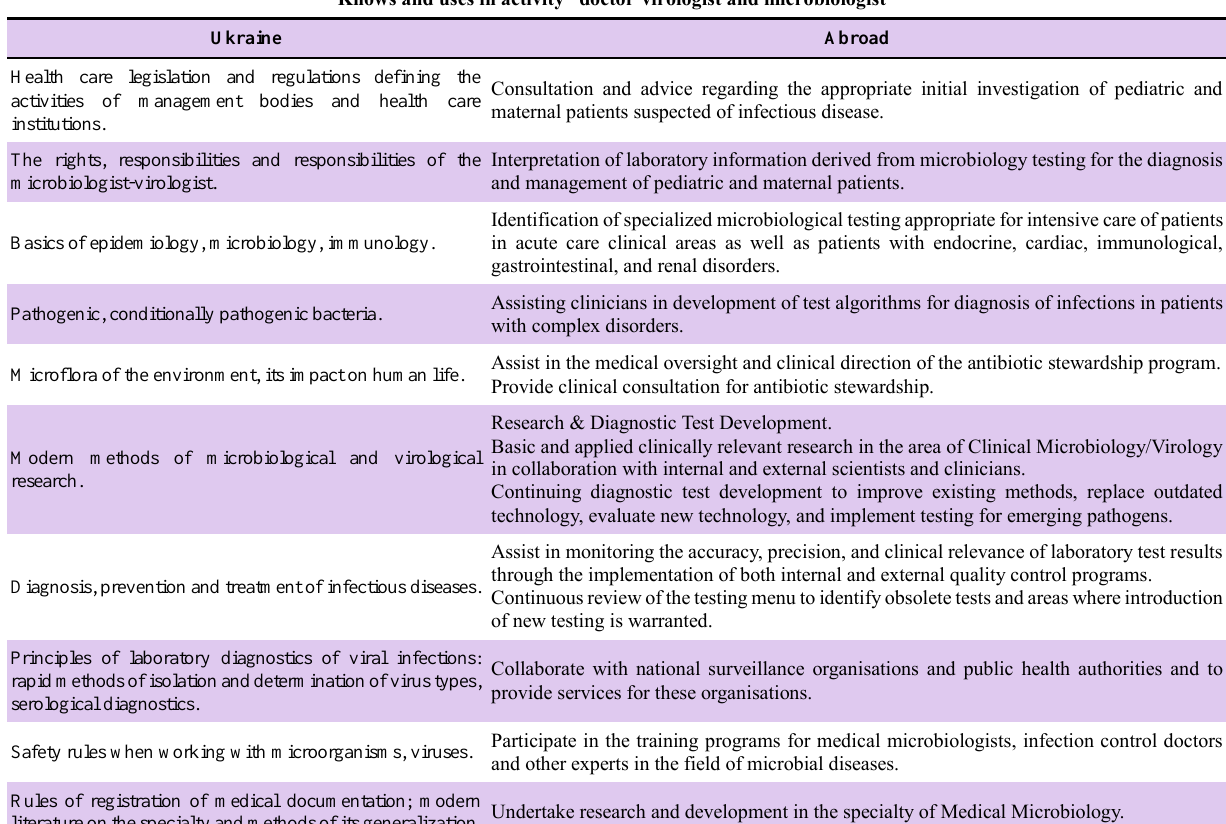
Table 1. Comparative analysis of qualification requirements of clinical or medical microbiologist in Ukraine and abroad. Knows and uses in activity “doctor-virologist and microbiologist” Ukraine